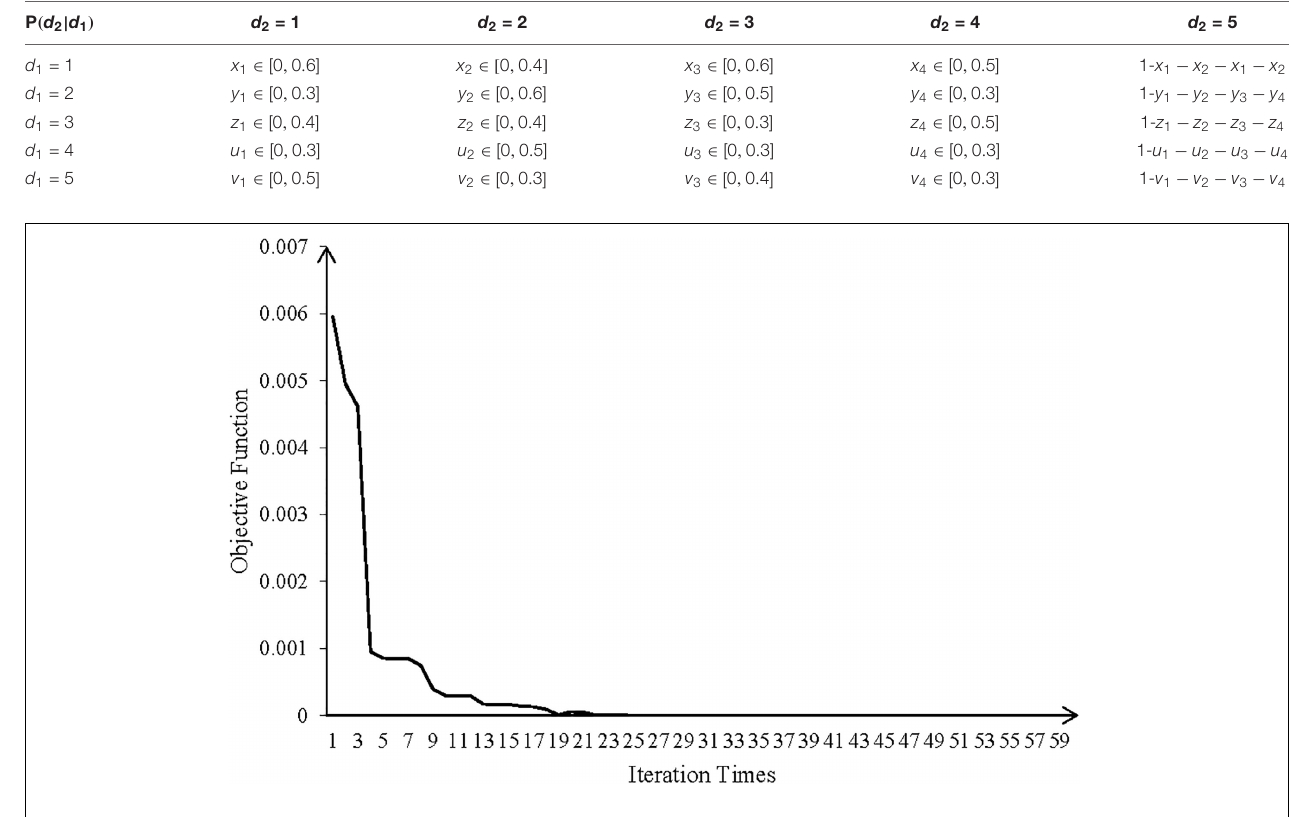
FIGURE 5 | The convergence curve of the fitness function.